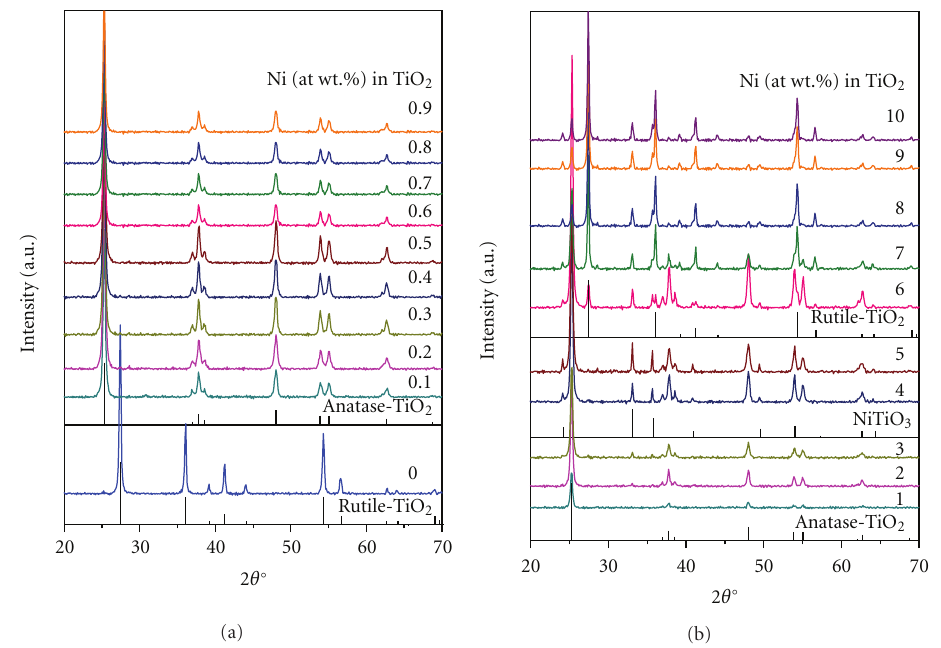
Figure 1: XRD patterns of Ni-doped TiO 2 powders, where Ni = 0, 0.1 to 0.9 at. wt.% (a), and Ni = 1 to 10 at. wt.% (b), formed at 550 ◦ C for 6h. Rutile TiO 2 : ICDD File number: 03-065-1118; anatase TiO 2 : ICDD File number: 03-065-5714; NiTiO 3 : ICDD File number: 04-006-6640. anatase TiO 2 (ICDD File number: 03-065-5714), rutile TiO 2 (ICDD File number: 03-065-1118), and NiTiO 3 compound (ICDD File number: 04-006-6640) are also presented in these